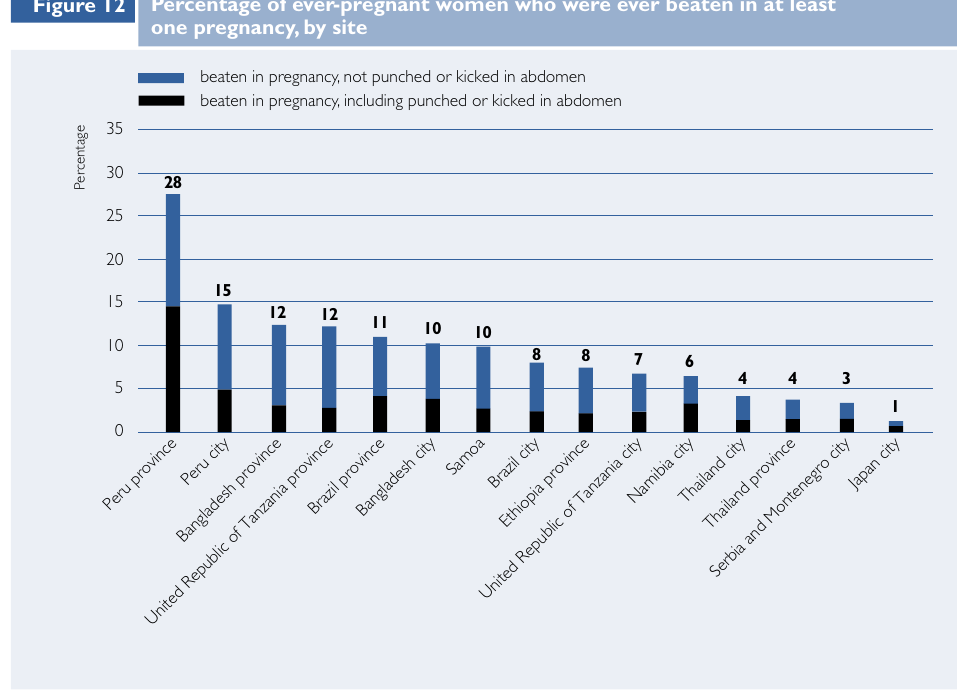
Percentage of ever-pregnant women who were ever beaten in at least one pregnancy, by site beaten in pregnancy, not punched or kicked in abdomen beaten in pregnancy, including punched or kicked in